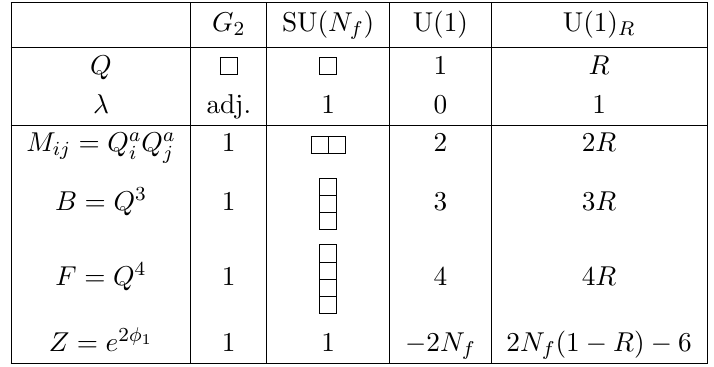
Table 5 . Quantum numbers of the G 2 SQCD with N f